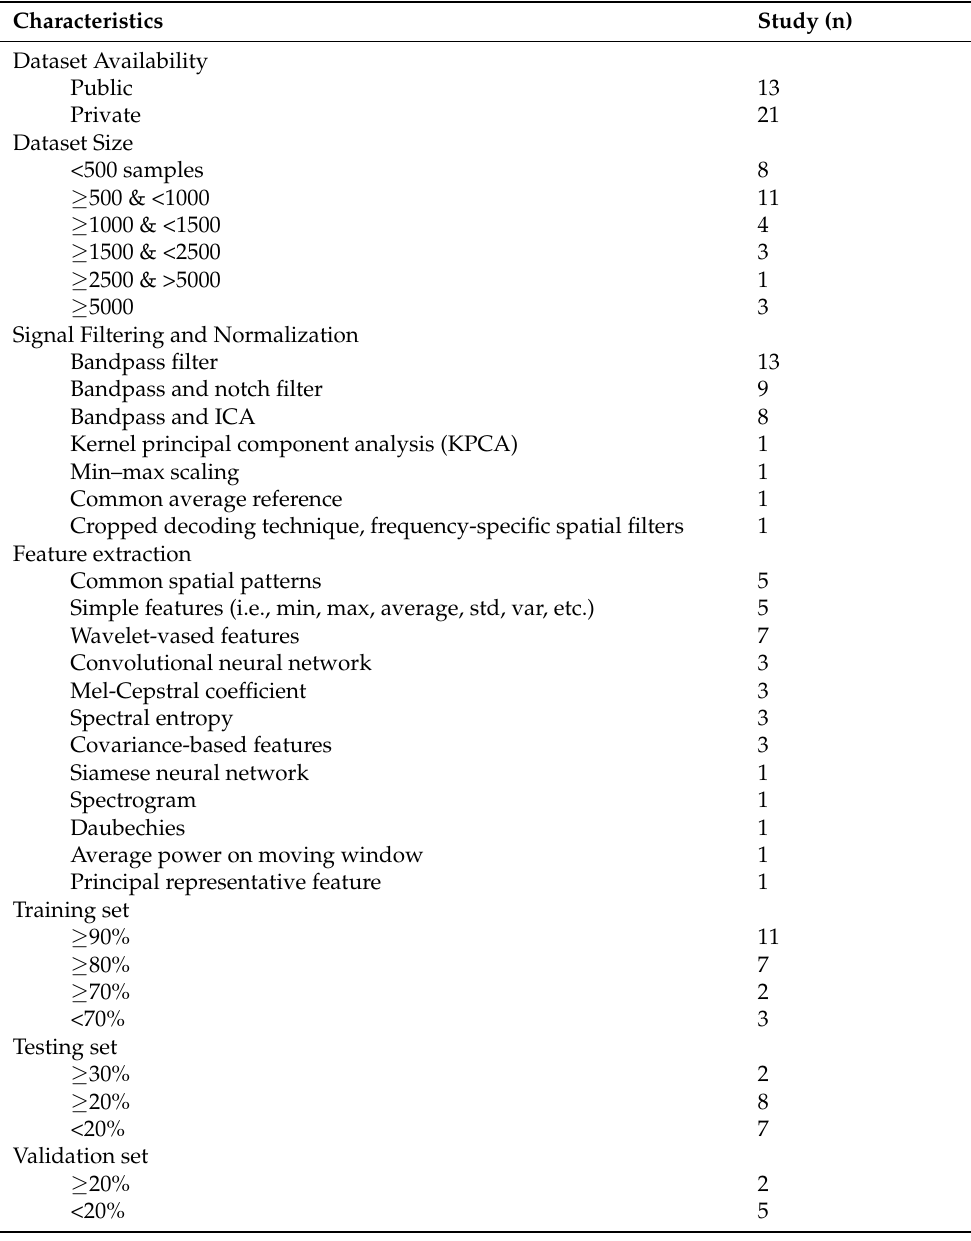
Table 3. Characteristics of Dataset Pre-processing and Feature